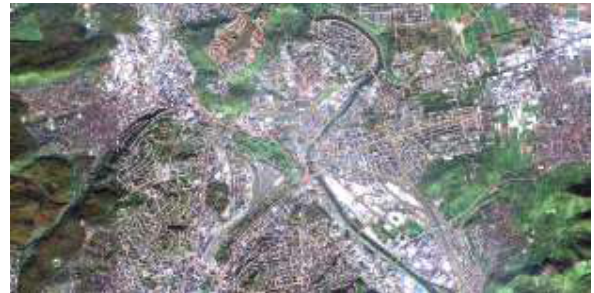
Figure 2. Exported image file of a disasterGIS